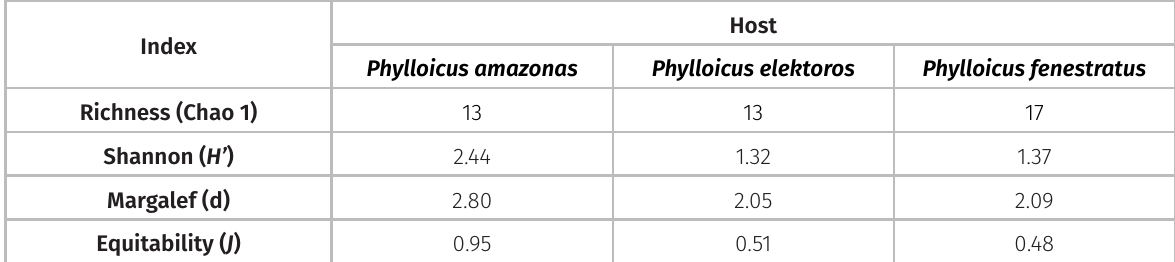
Table II. Richness, diversity indexes and equitability of fungal taxa associated with Phylloicus spp. (Trichoptera: